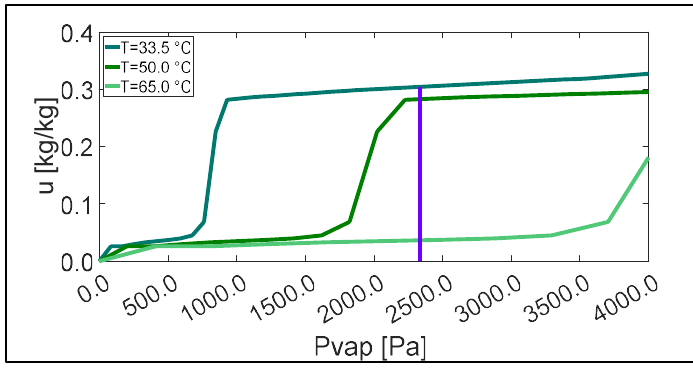
Figure 10. Isotherms of zeolite [14].